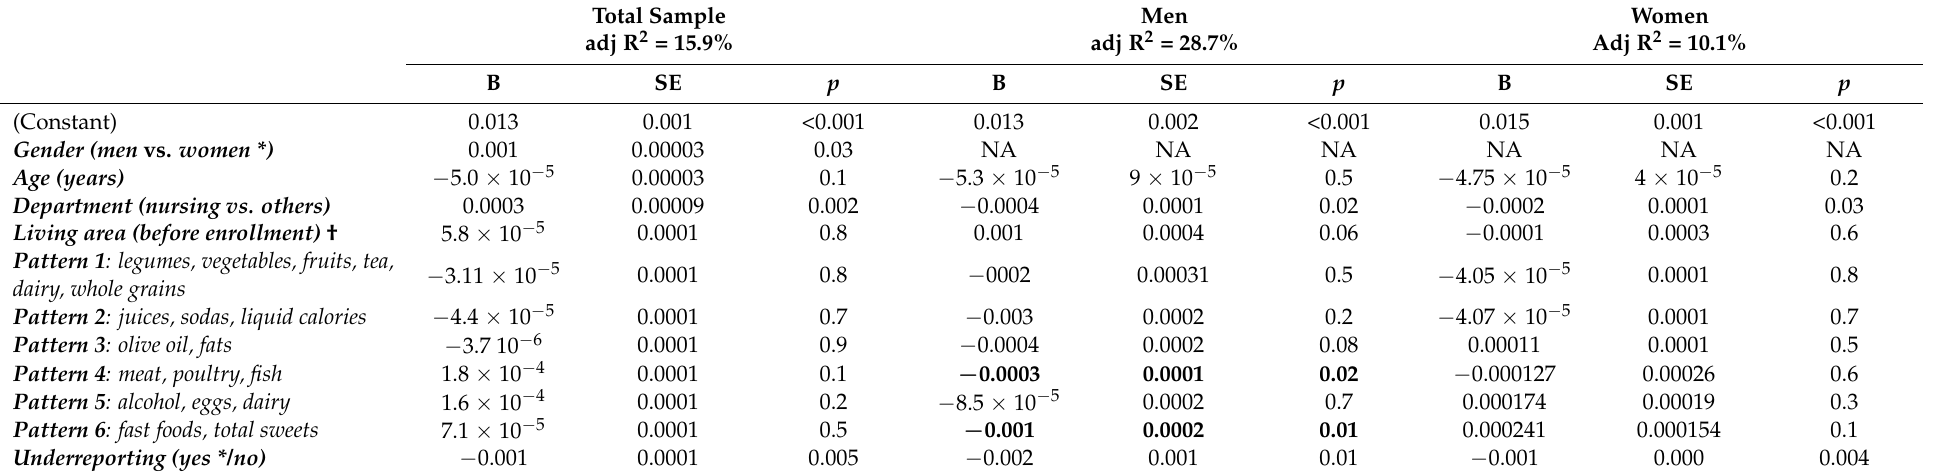
Table 5. Linear regression analysis for l/WC in the total sample, men and